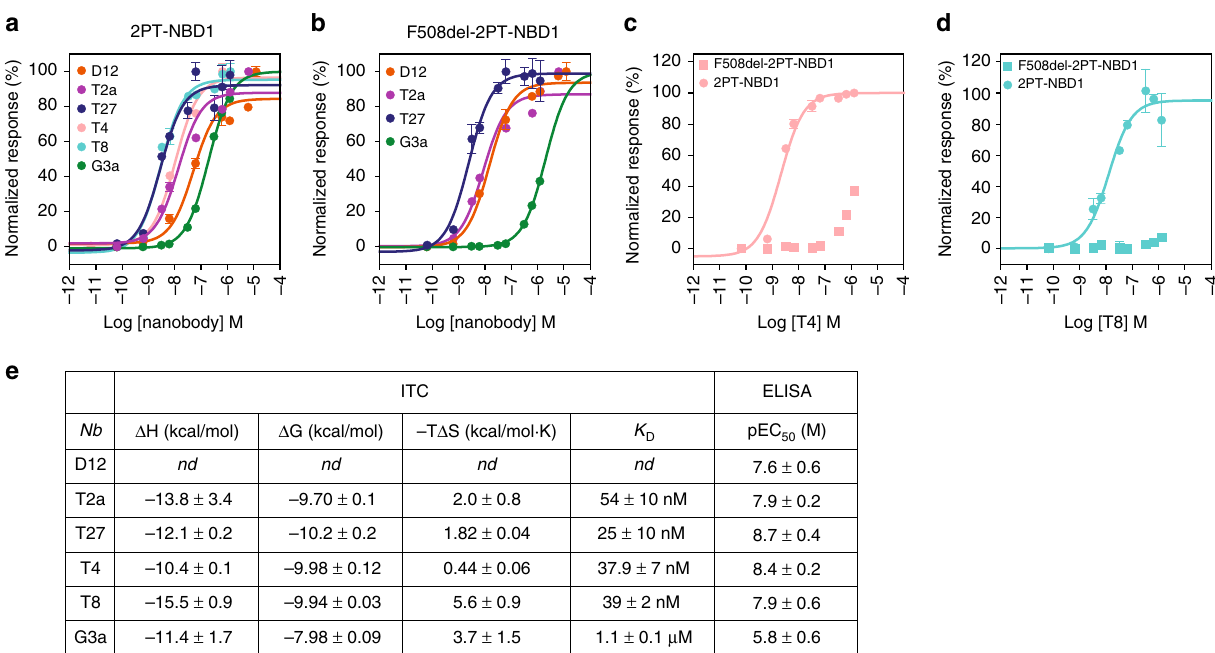
Fig. 1 Binding of NBD1-speci fi c nanobodies to isolated 2PT-NBD1 and F508del-2PT-NBD1. a Nanobody binding to 2PT-NBD1 measured by ELISA. Biotinylated 2PT-NBD1 was immobilized on neutravidin-coated plates and incubated with increasing concentration of each nanobody. Binding of nanobody was followed by immunodetection of the His 6 -tag (see Methods). Representative curve of 3 independent experiments is shown. Error bars represent the standard deviation (SD) of duplicates. Data were normalized to maximum signal for each nanobody separately. b Nanobody binding to F508del-2PT-NBD1 measured by ELISA as described in ( a ). c Nanobody T4 binding to 2PT-NBD1 and F508del-2PT-NBD1. Data were normalized to maximum signal of T4 binding to 2PT-NBD1. d Nanobody T8 binding to 2PT-NBD1 and F508del-2PT-NBD1. Data were normalized to maximum signal of T8 binding to 2PT-NBD1. e Thermodynamic parameters of nanobody binding to 2PT-NBD1 determined using isothermal calorimetry (curves shown in Supplementary Fig. 2), and pEC 50 determined by ELISA ( a ). K D values determined by ITC represent mean ± SD ( n = 3). Source data are provided as a Source Data fi le